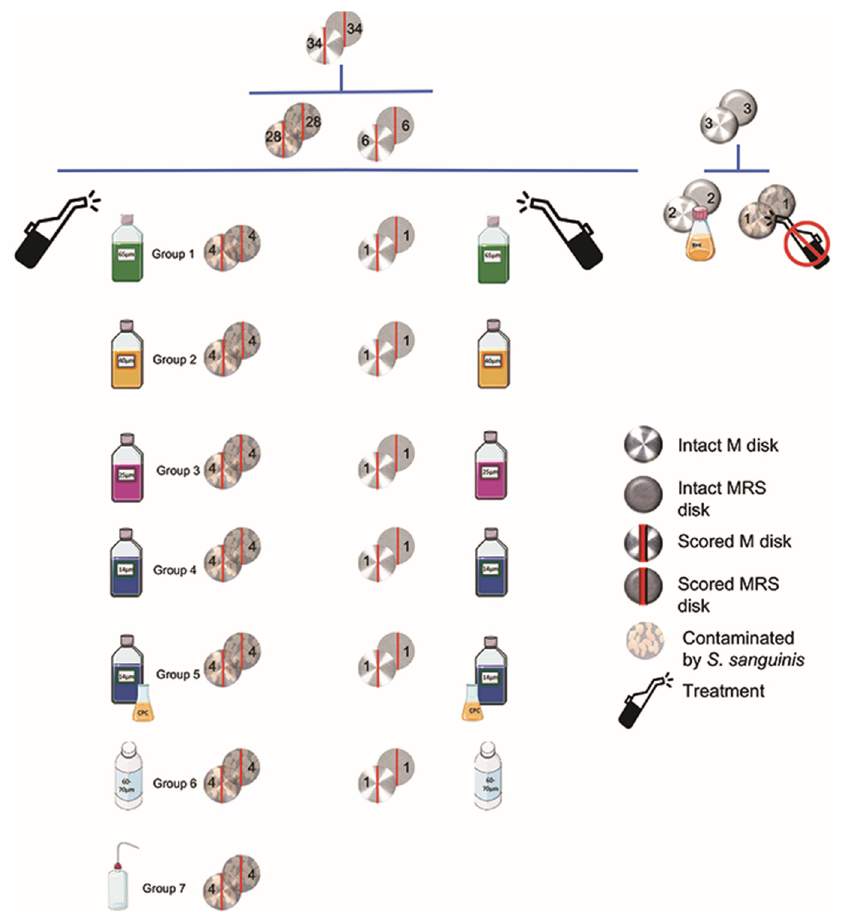
Figure 1. Assessment of ability of different powders to remove biofilm—experimental design. Specifically, a total of 34 machined (M) and 34 moderately rough surface (MRS) discs were examined. A total of 28 M and 28 MRS were contaminated, while 6 M and 6 MRS served as controls and were left uncontaminated. Thus, 4 M and 4 MRS discs were treated with sodium bicarbonate powder 65 µ m (group 1), sodium bicarbonate powder 40 μ m (group 2), glycine powder (group 3), erythritol powder (group 4), and the addition of cetylpyridinium chloride (group 5), calcium carbonate (group 6), and distilled water (group 7), respectively; the same treatments were applied to 1 not contaminated disc per group.